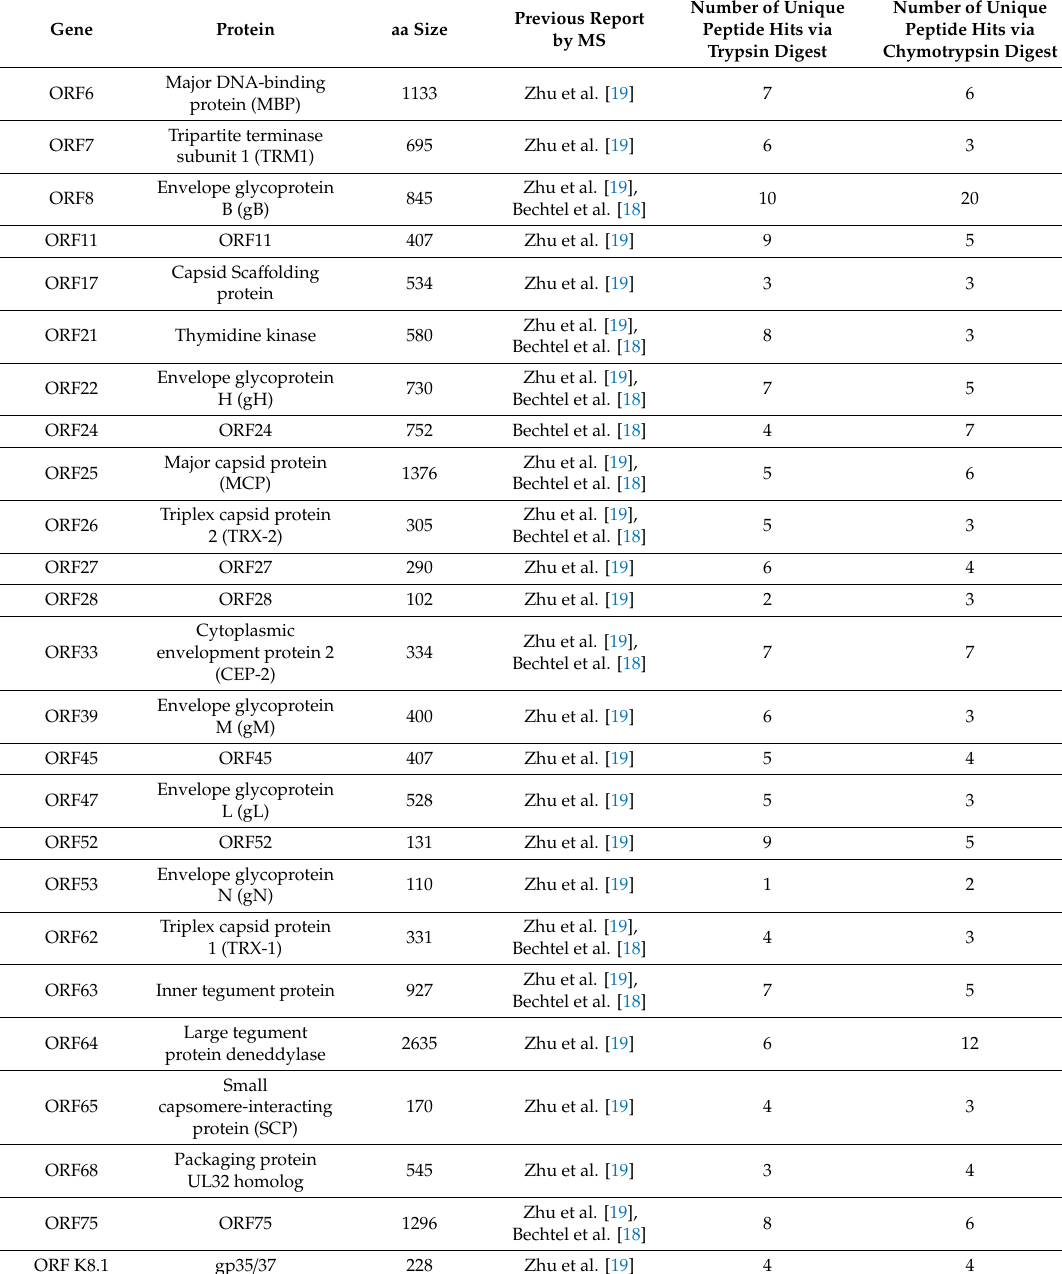
Table 1. Proteins identified in the VT fraction in our study that were previously reported by mass